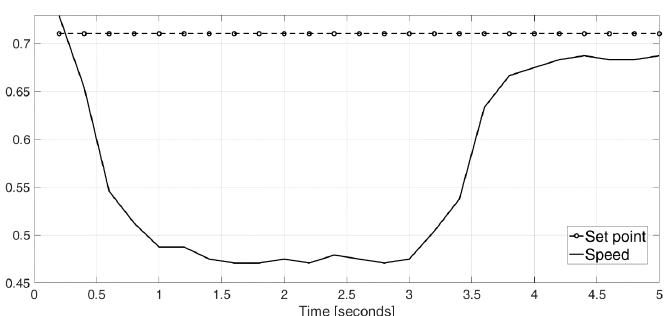
Figure 11. Experimental speed results (P.U.) when the PID controller is implemented with a disturbance of 1.5 times (P.U) the nominal load.